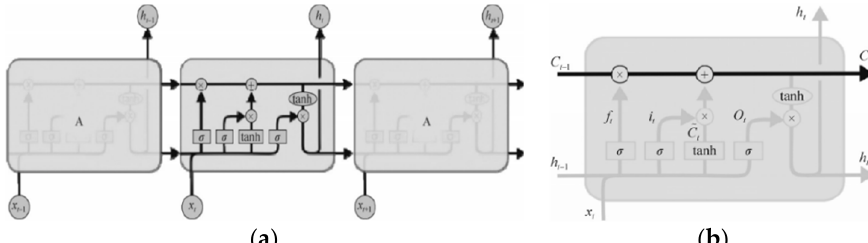
Figure 2. ( a ) The chain structure of Long Short-Term Memory. It takes the output of a LSTM cell at previous time step as the input of the LSTM cell at current time step and forms a multilayer LSTM; ( b ) Details of the information transfer process. The memory cell is like a conveyor belt, which directly passing through the whole cell.